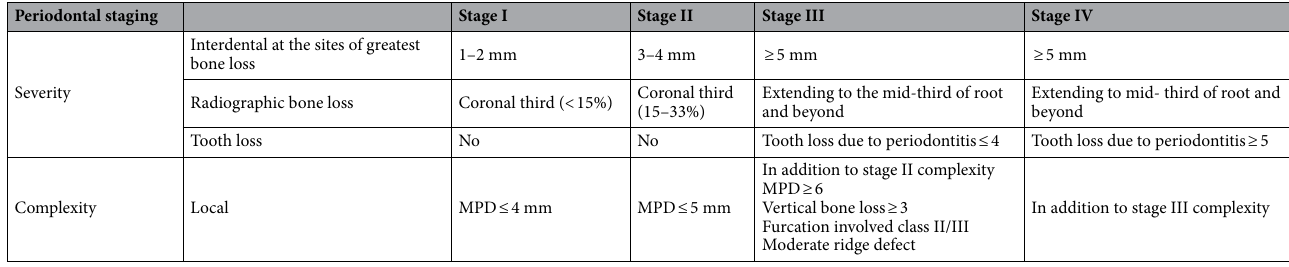
Table 1. Periodontal staging according to the new classification of AAP/EFP 3 . MPD, mean probing depth.